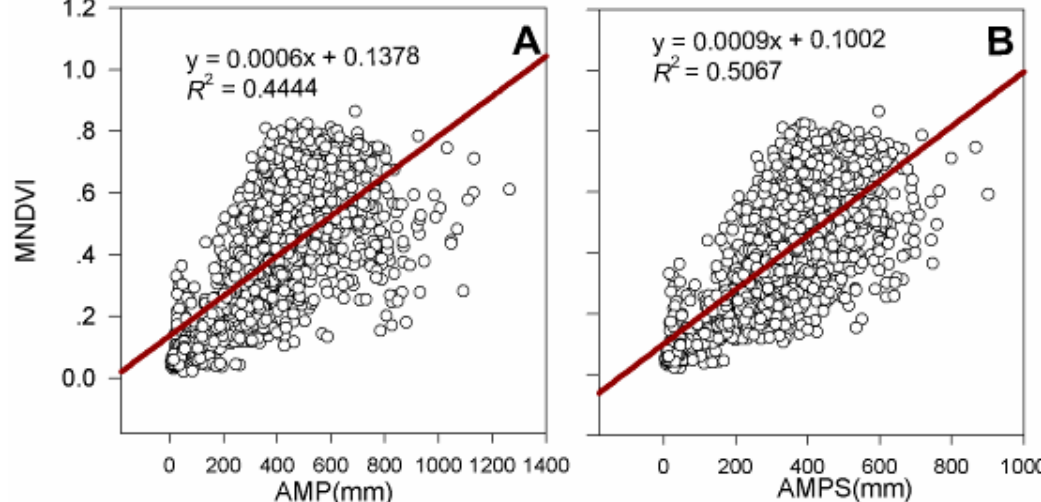
Figure 7. Correlation coefficients between MNDVI and climatic factors in the entire region (all the observatory stations) in the Tibetan Plateau from 1982 to 2002. ( A ) and ( B ) represent the relationship of MNDVI with AMP and AMPS, respectively. The dark red solid line denotes the fitting